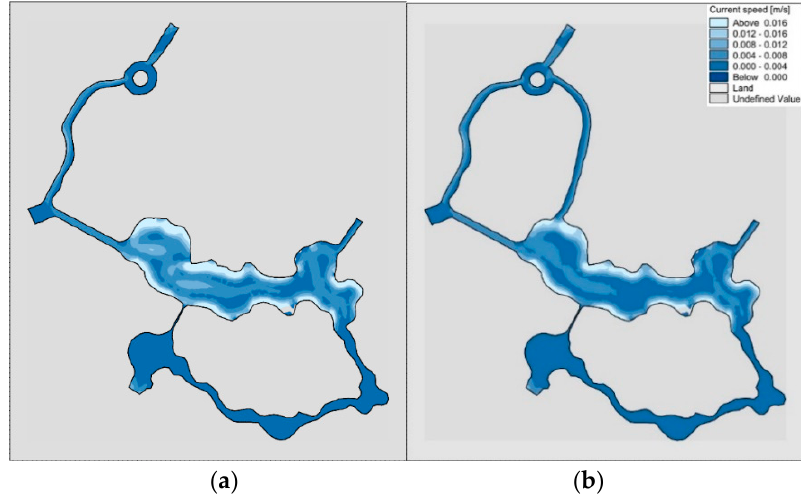
Figure 12. Comparison of flow field in “unilateral” and “bilateral” rivers without water diversion. ( a ) “unilateral” river; ( b ) “bilateral” rivers.